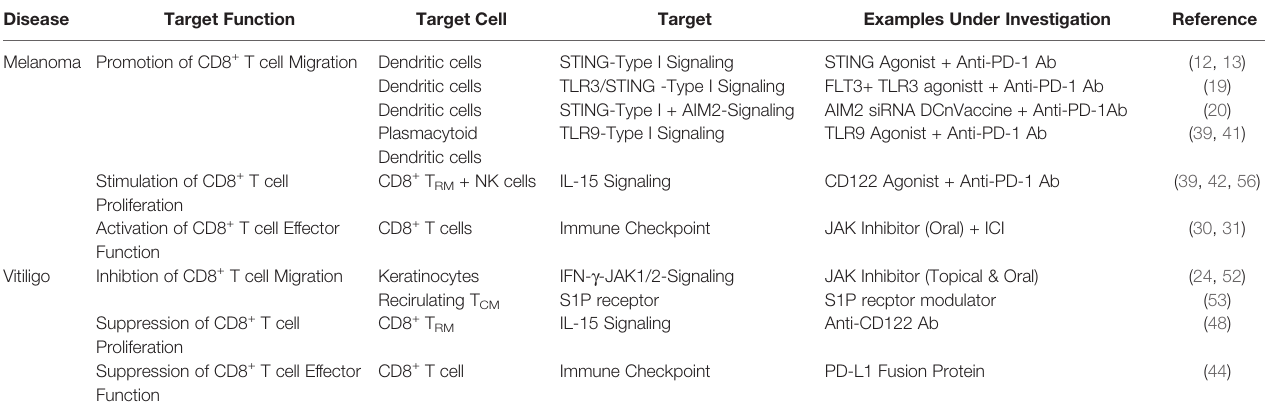
TABLE 1 | Future Approaches for Targeting CD8+ T cell Immune Response in Melanoma and